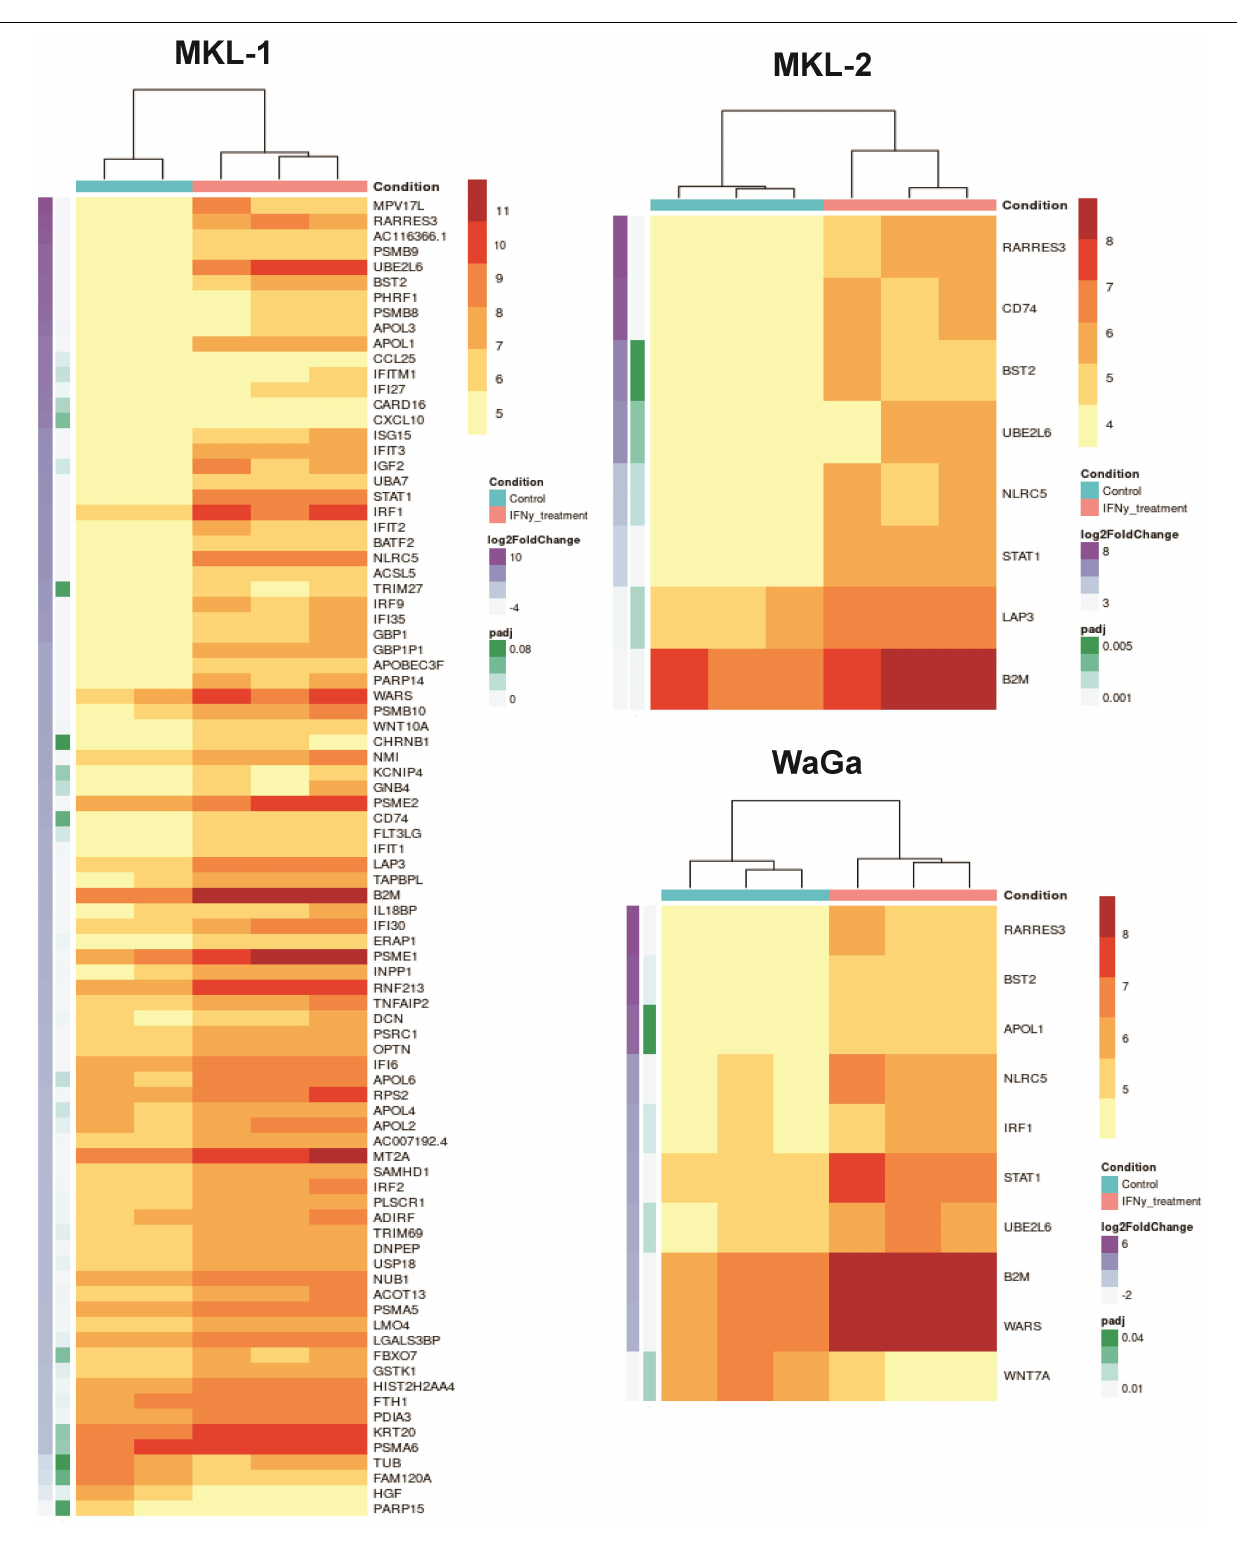
Frontiers in Microbiology |